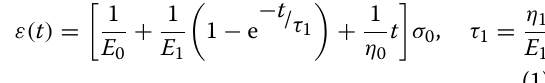
where ε ( t ) is creep strain; ε + and ε − are strain on the upper (tension) and bottom (compression) surfaces of the specimen, respectively; E 0 and E 1 are instantaneous and delayed elastic modulus, respectively; τ 1 is retardation 1 − 1 e ) of its total deforma- time to produce 63.21% (or (cid:31) tion; σ 0 is applied stress; t is time; η 0 and η 1 are viscosities of the dashpot in the Maxwell and Kelvin units, respec- tively; J ( t ) is creep compliance. From Eqs. (1) and (3), J ( t ) can be expressed as: